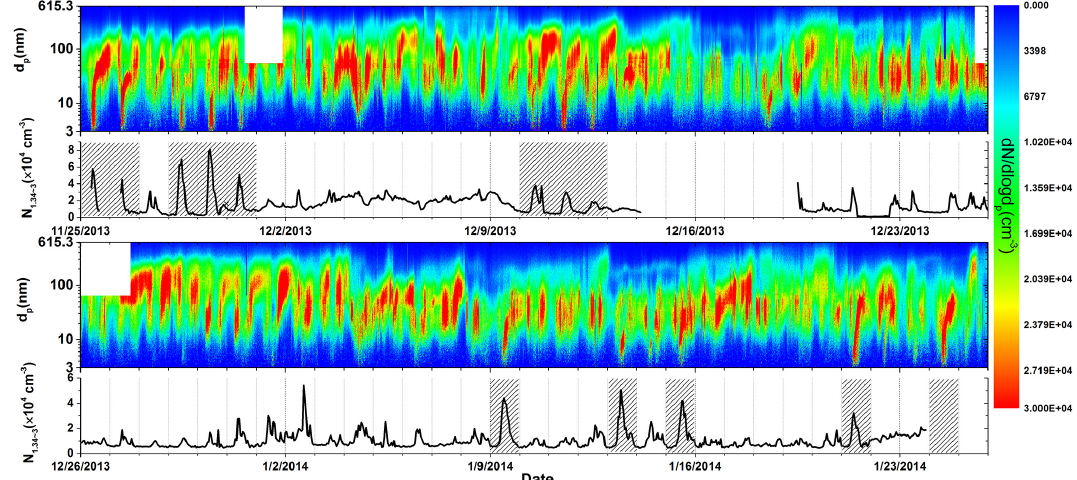
Figure 1. Contour plot for particle size distributions of 3–615nm and plot of number concentrations of sub-3nm clusters/particles ( N 1 . 34 ∼ 3 ) during 25 November 2013–25 January 2014. Data were occasionally missing because of the maintenance and minor breakdown of instru- ments. NPF events are illustrated with